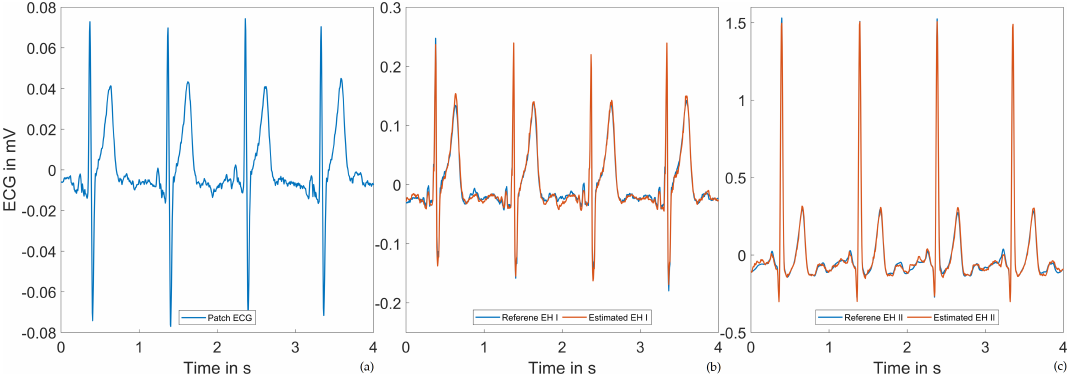
Figure 9. Example ECG signals of Subject 1 in the supine position: ( a ) Patch ECG. ( b ) Reference and estimated Einthoven I ECGs. ( c ) Reference and estimated Einthoven II ECGs.